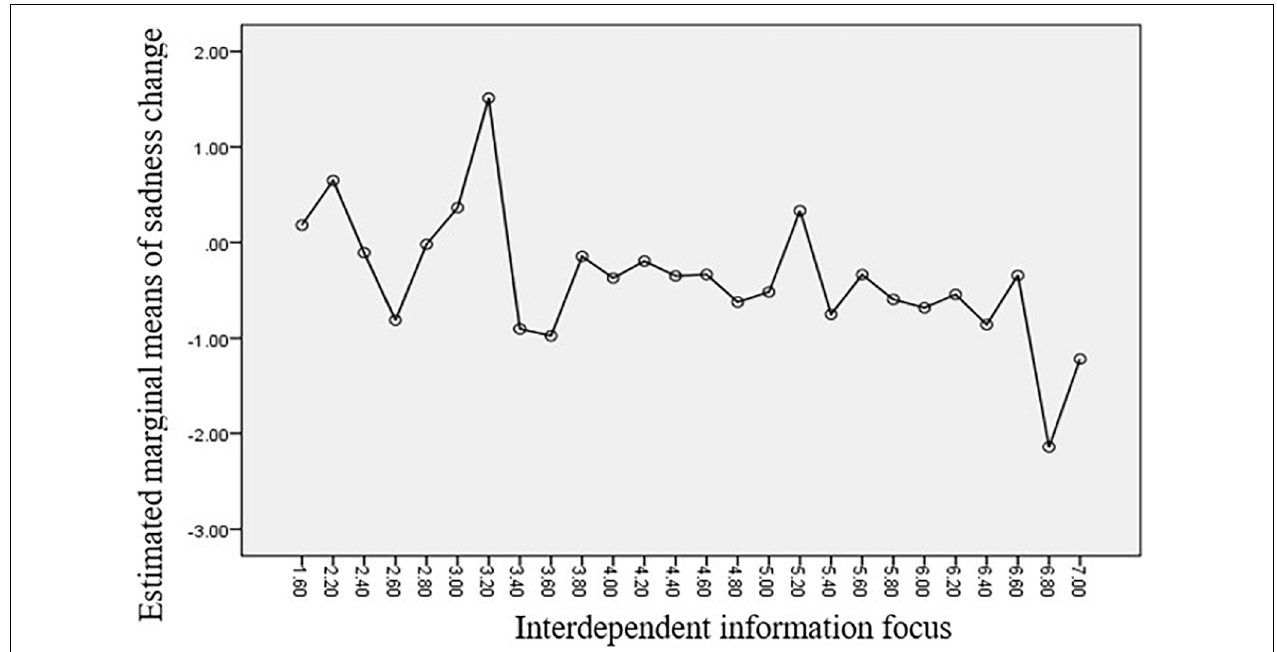
FIGURE 4 | Estimated marginal means of sadness